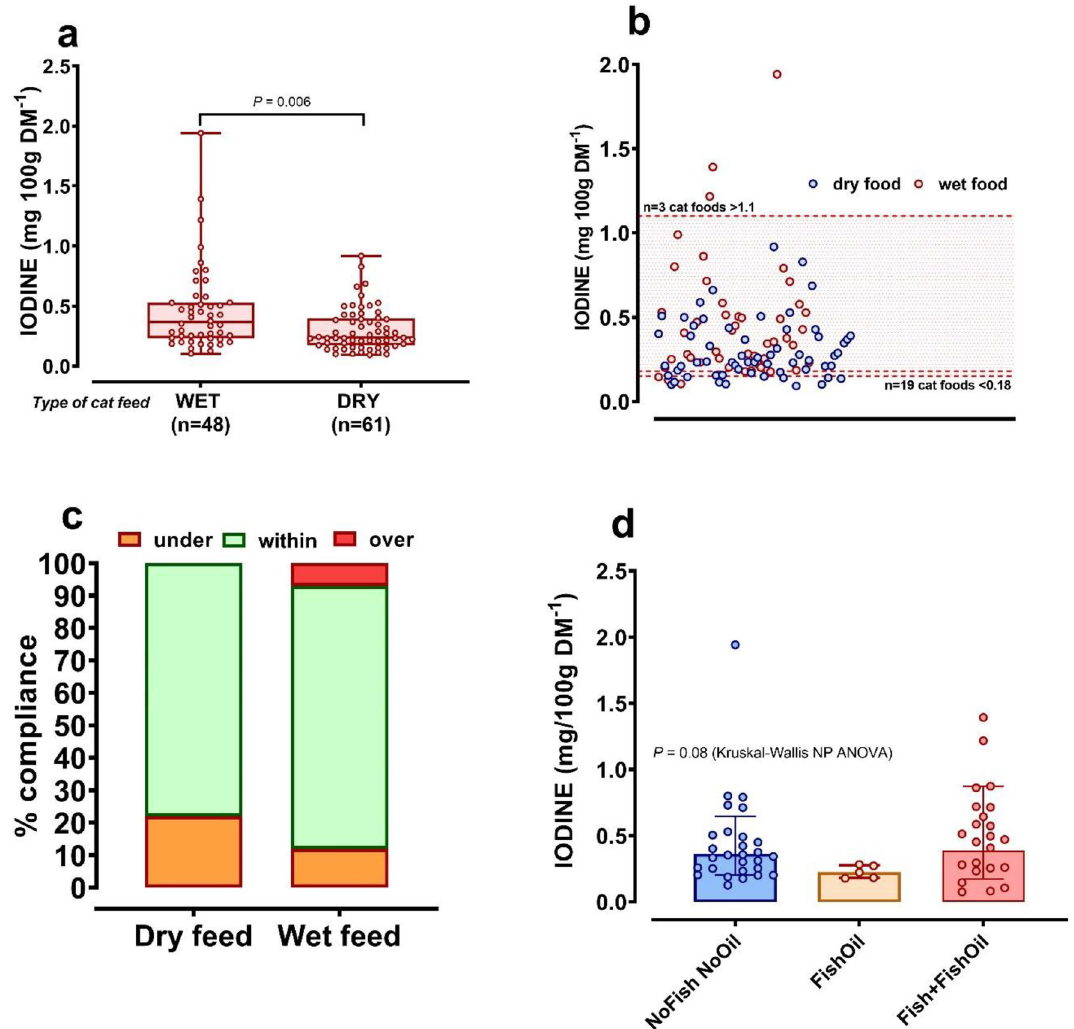
Figure 2. Iodine content of complete, wet and dry, dog and cat foods. Freeze-dried wet and dry pet foods were homogenised and duplicate samples (100–200 mg) were digested with TMAH for subsequent analysis of their iodine content by ICP-MS. (a) Iodine content of wet and dry cat foods where each food is represented by an individual dot, boxes show upper to lower quartiles with line at median, whiskers from min to max, data analysed by Mann–Whitney U-test. (b) Assessment of compliance of individual wet (red dots) and dry (blue dots) cat foods with FEDIAF recommendations for the nutritional maximum (1.1 mg/100 g DM) and minimum (0.18 [kitten], 0.17 [cat], mg/100 g DM −1 ) iodine content of pet foods, represented by dotted lines. (c) Data are proportions of cat feeds analysed under, within-range or over FEDIAF guidelines. (d) Iodine content of wet foods grouped according to whether the feed contained no fish and no fish-oil (NoFishNoOil), with only fishoil added (FishOil) or with both Fish and fish oil (Fish + FishOil). Dots represent individual foods, boxes show the geometric mean and whiskers show the geometric standard deviation of the data. Data were analysed by non- parametric analysis of variance (NP ANOVA). Statistical significance was accepted at P <